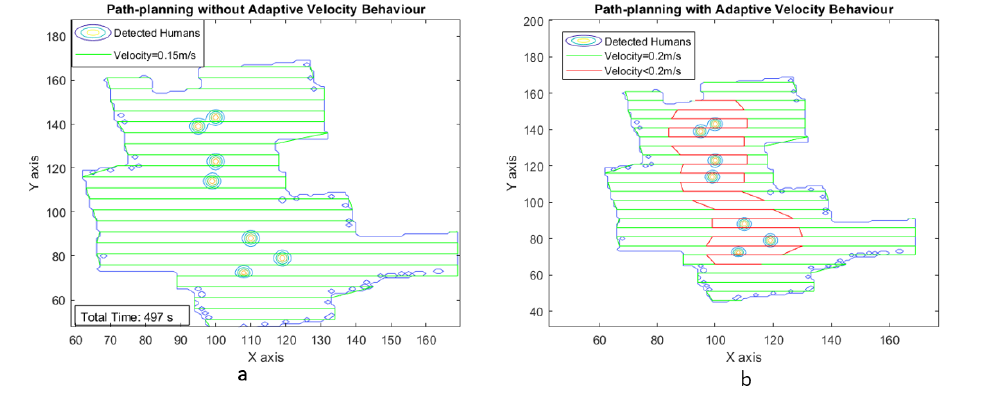
Figure 13. Zig-zag-based area coverage path generated for scenario II.